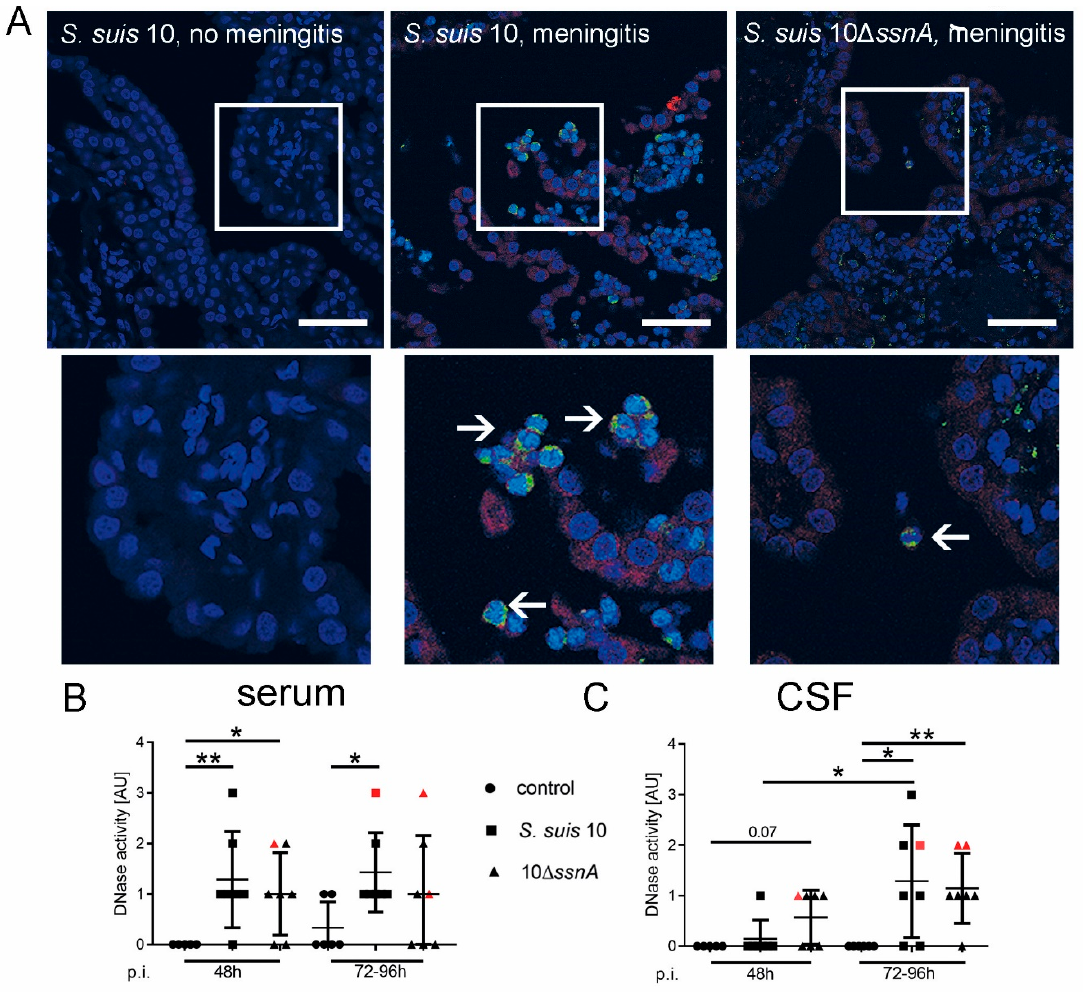
Figure 4. Host DNases are detectable and active during S. suis meningitis in choroid plexus, CSF and serum. ( A ) By immunofluorescence staining, we could show that the amount of DNase 1 in the choroid plexus is different in animals with inflammation, compared to animals without inflammation of the choroid plexus. In the choroid plexus of an infected pig without clinical signs of CNS disorders only weak DNase 1 signals were detected in the early phase experiment. In pigs with clinical signs of CNS disorders a high DNase 1 signal in the region of the choroid plexus epithelial cells was observed. PR-39 signal, as a marker for neutrophils, was found in these pigs as well (blue = DNA (Hoechst); green = PR-39; red = DNase 1 (scale bar upper panel = 50 µm; lower panel = 20 µm; arrows mark transmigrating or already transmigrated PR-39 positive neutrophils). Activity of DNases was observed in serum ( B ) and in CSF ( C ) of all pigs of the early phase experiment. A significant increase of DNase activity post-infection was found in serum for both infection groups after 48 h and for the S. suis 10-infected group also after 96 h. In CSF after 96 h, a higher increase was observed than after 48 h in both infection groups. Data shown as mean ± SD. Statistical analysis: unpaired Mann–Whitney test (* p < 0.05, ** p <